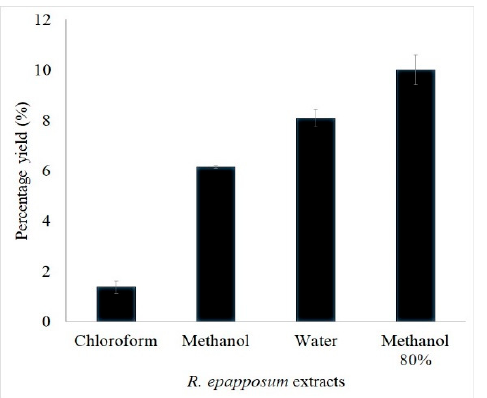
Figure 1. Percent yield of chloroform, methanol, aqueous, and 80% methanol extracts of R. epappo- sum